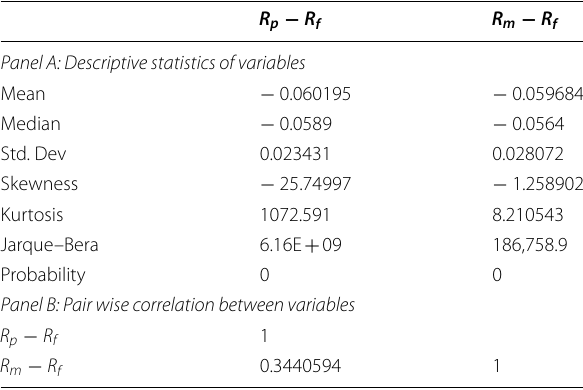
Table 2 Table showing Descriptive Statistics of Variable and Cross correlation results